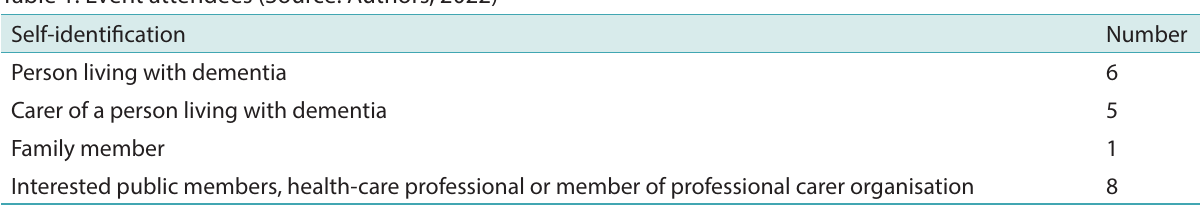
Table 1. Event attendees (Source: Authors,